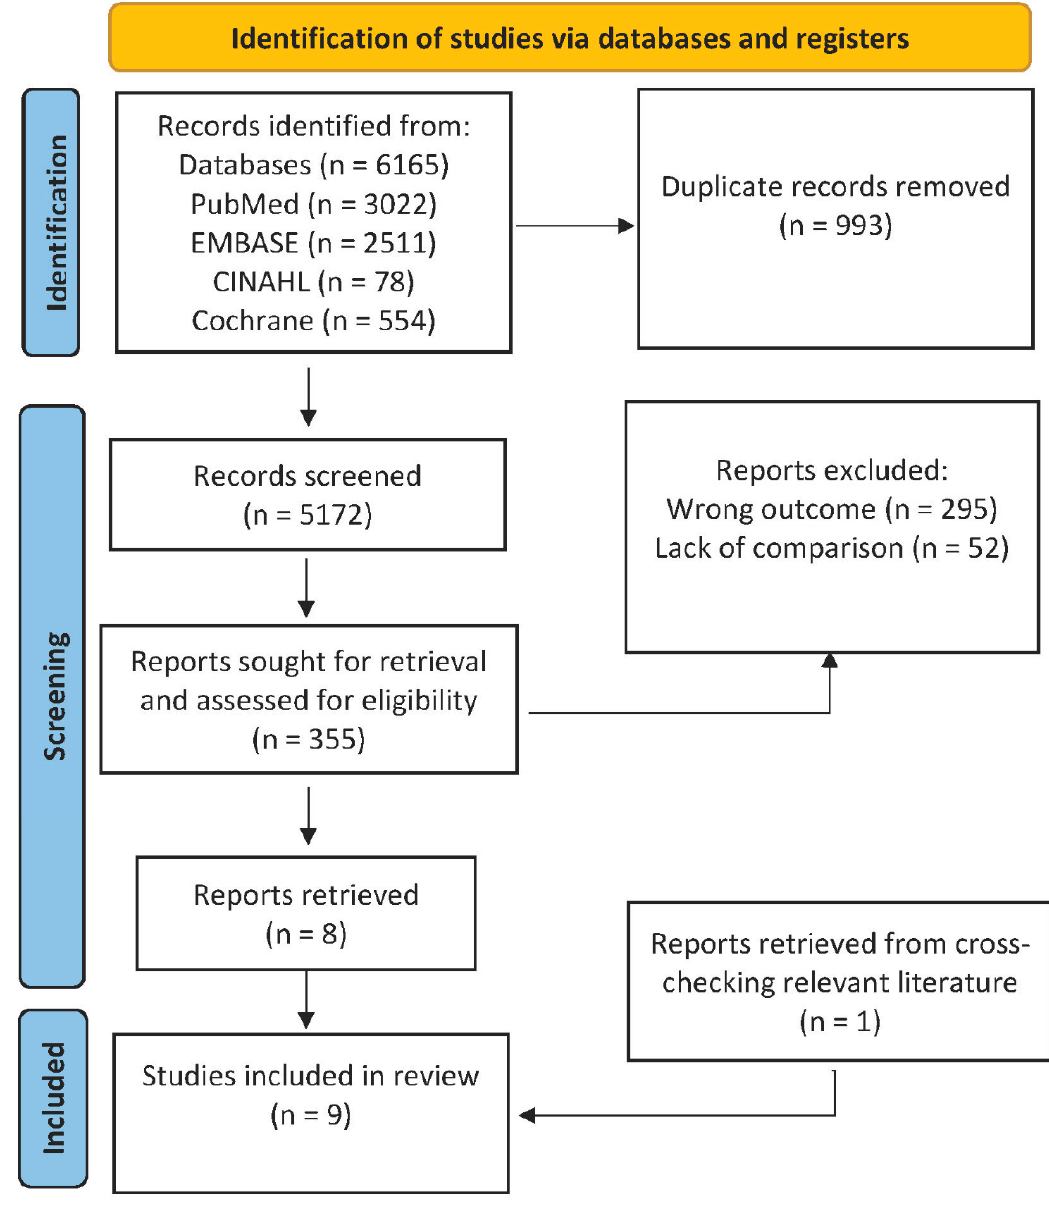
Figure 1. Diagram of the selection process.